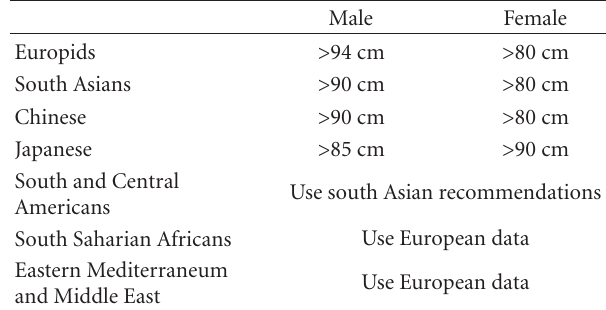
Table 3: Values of waist circumference recommended by IDF criteria, according to